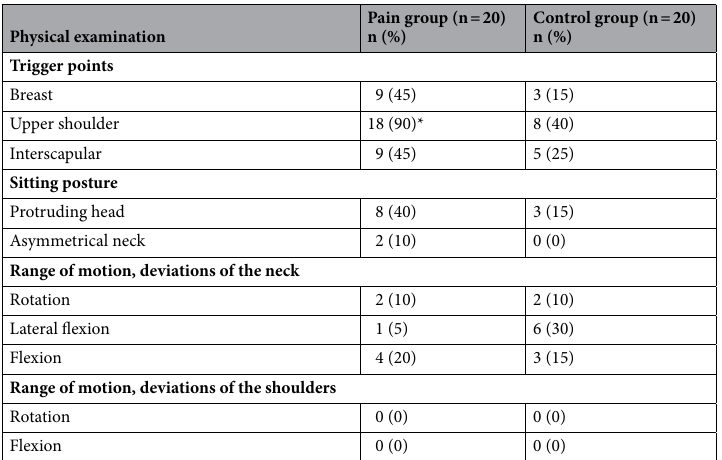
Table 1. Frequency of trigger points and physical deviations. *Statistical significant difference between groups (Bonferroni adjusted alpha level of 0.005